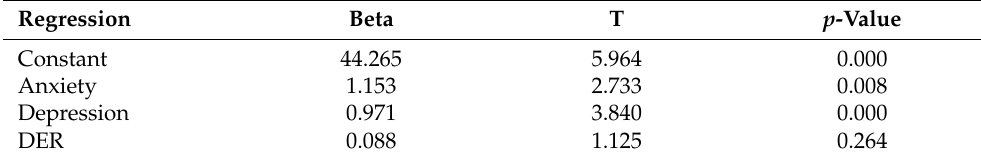
Table 5. Prediction analysis of ES as a mediator between mothers’ anxiety, depression, and DER.